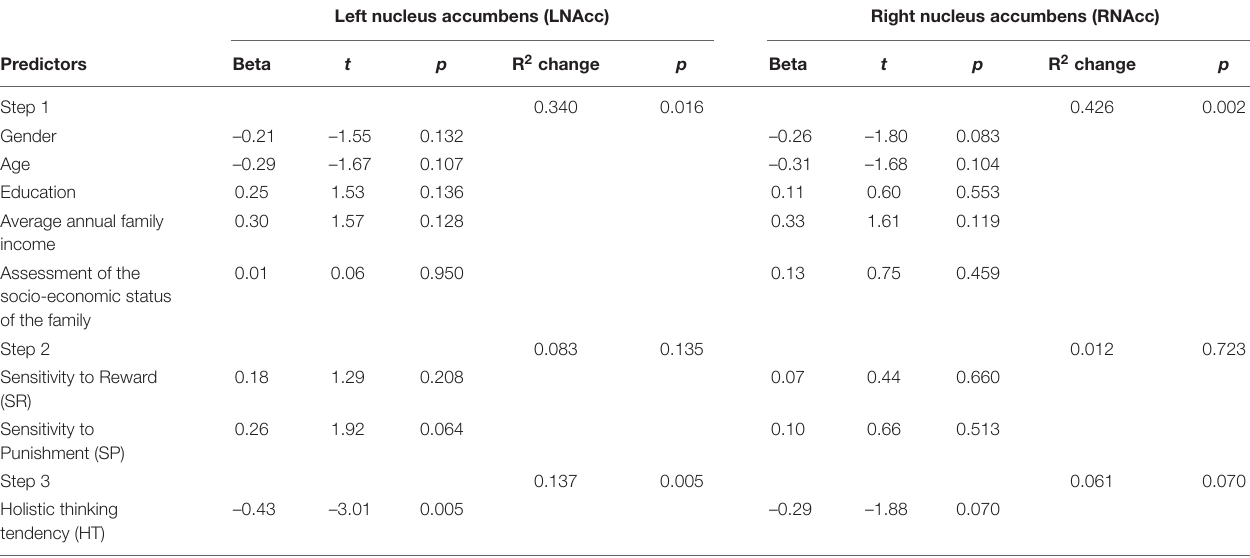
TABLE 2 | Hierarchical regression predicting the volume of left and right nucleus accumbens. Left nucleus accumbens (LNAcc)